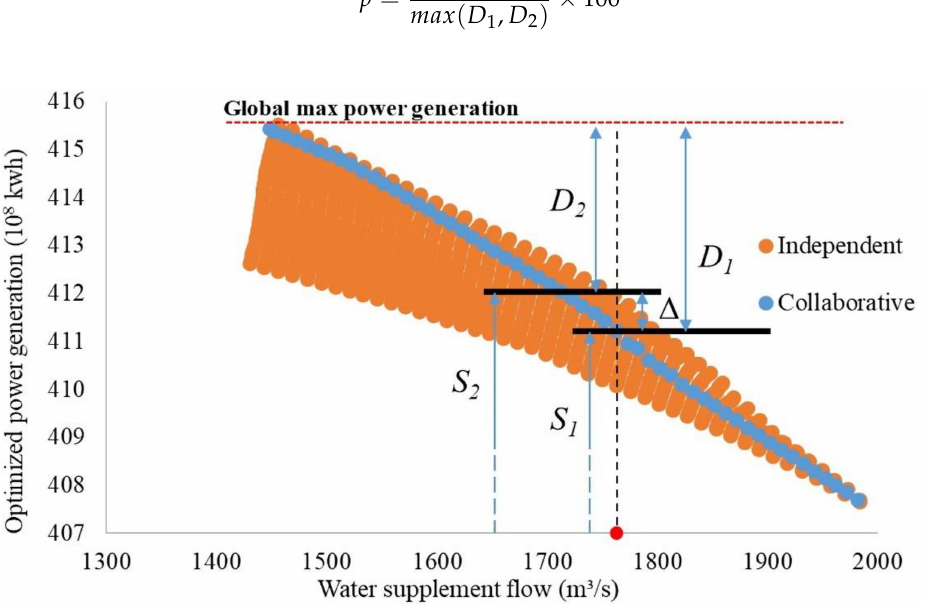
Figure 11. Effect evaluation method of “collaborative independent” joint